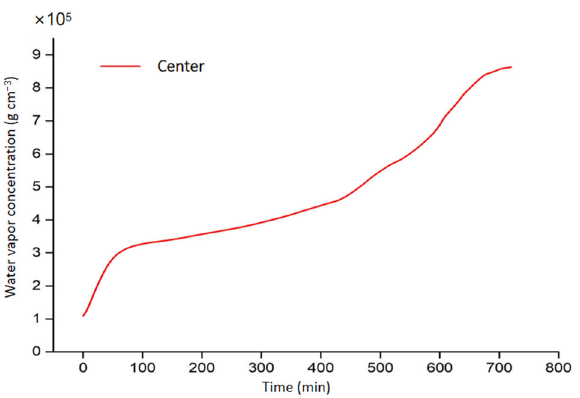
Figure 11. The water vapor content in potato samples with RF drying duration from simulation.